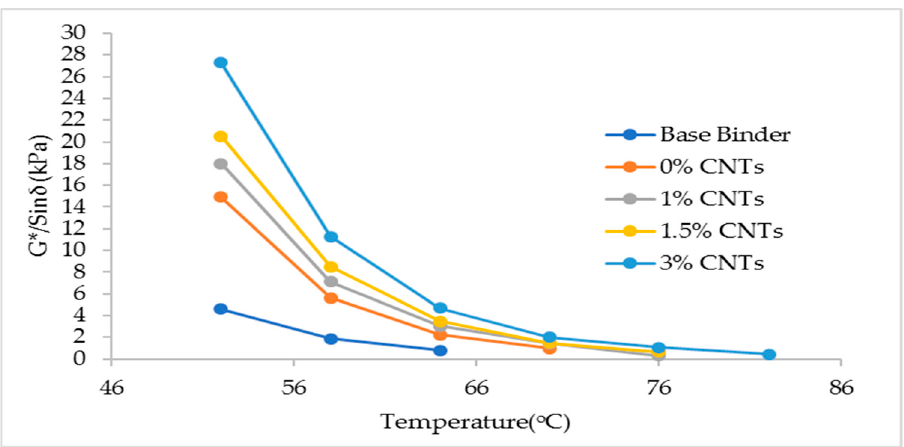
Figure 11. Rutting parameter (G*/Sin δ ) versus temperature for unaged asphalt binder at 10 rad/s.